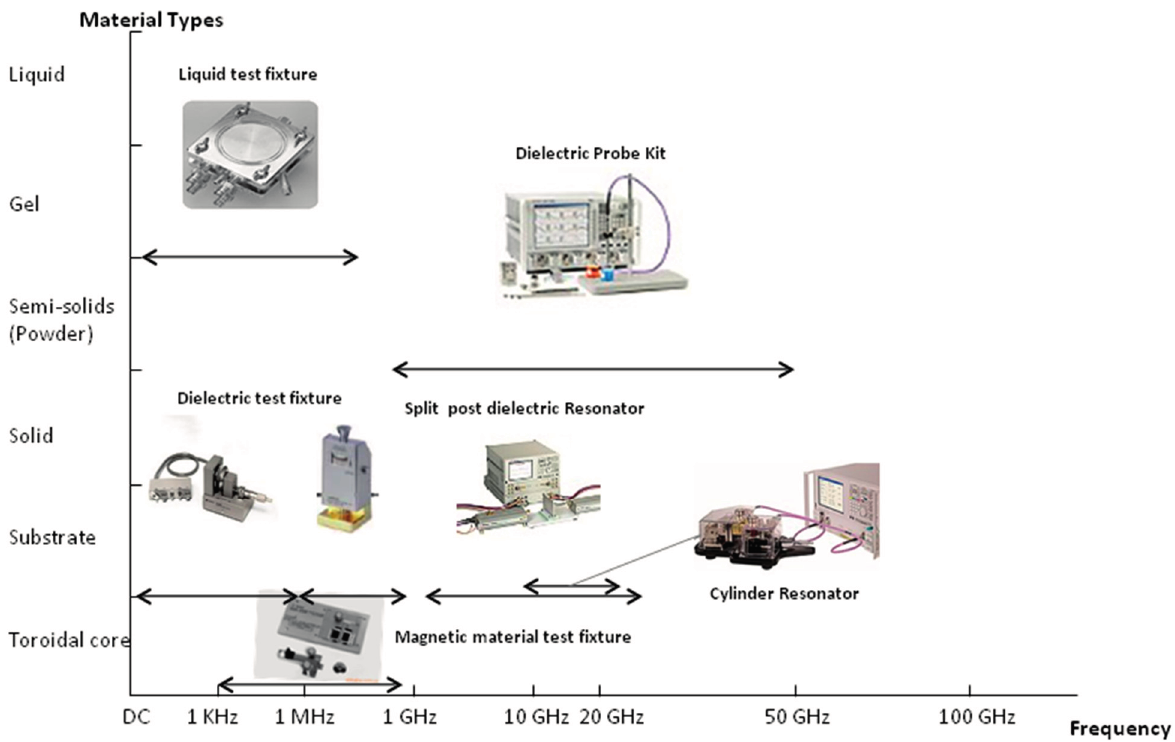
Figure 3. The material measurement